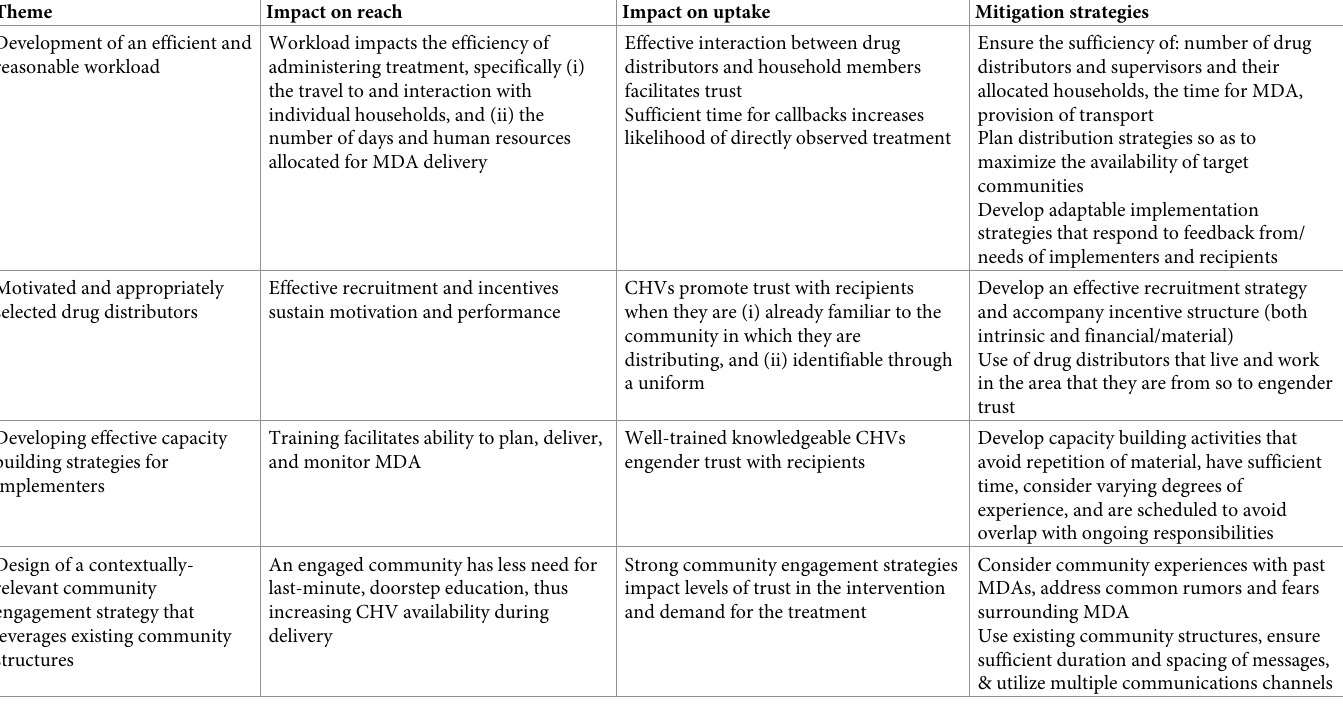
Table 2. Themes associated with reach and uptake and actionable mitigation strategies.